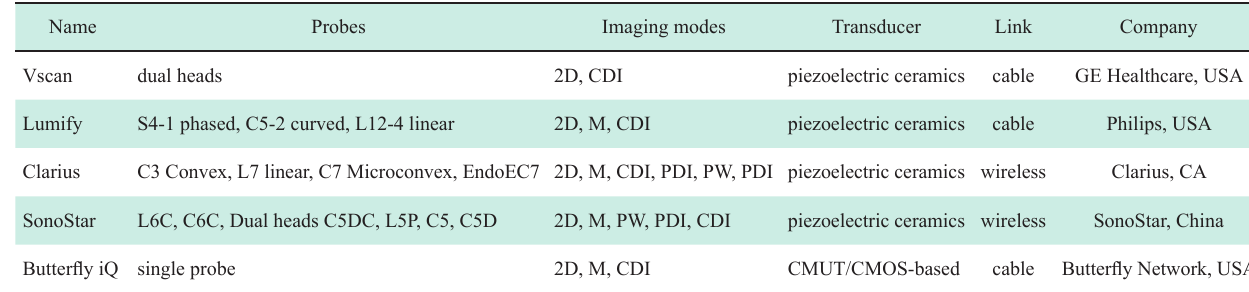
Table 1 List of portable handheld ultrasound systems with